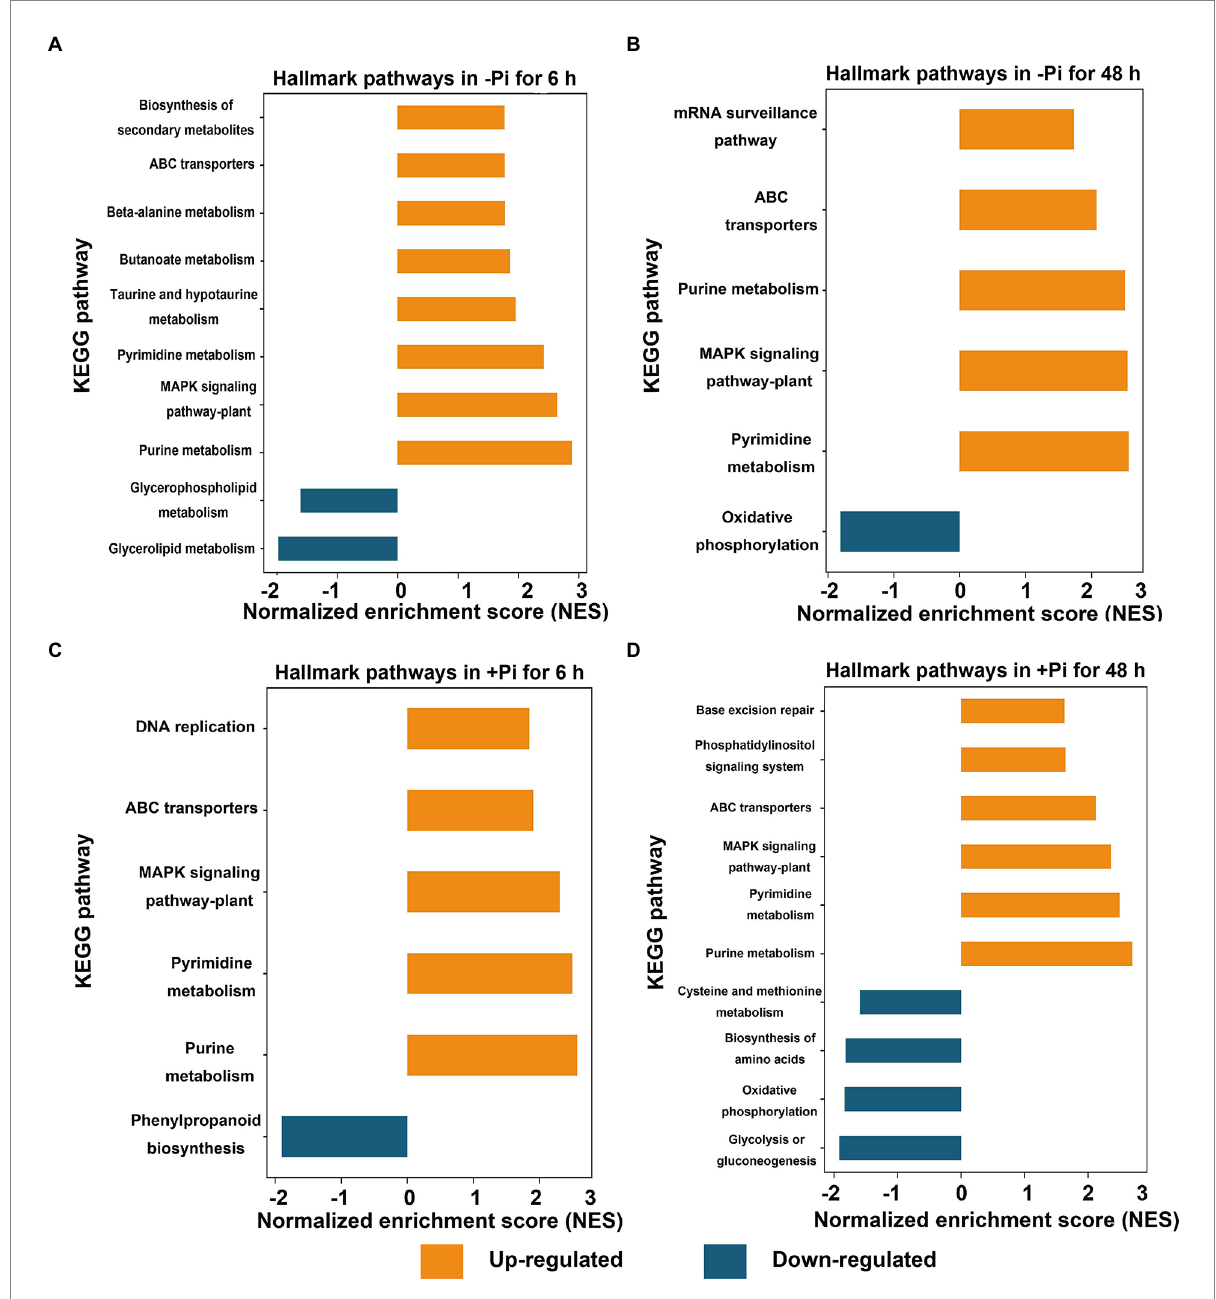
FIGURE 2 GSEA of significantly up (FDR < 0.1, NES > 1.5; orange) or down (FDR < 0.1, NES < –1.5; blue) regulated metabolic pathways in response to Pi starvation (–Pi) for 6 h (A) and 48 h (B) and Pi recovery (+Pi) for 6 h (C) and 48 h (D) of phosphorylated proteins, respectively. Gene sets with an FDR < 0.01 are displayed using bar plots. FDR, false discovery rate; GSEA, Gene Set Enrichment Analysis; NES, normalized enrichment score; Pi, intracellular